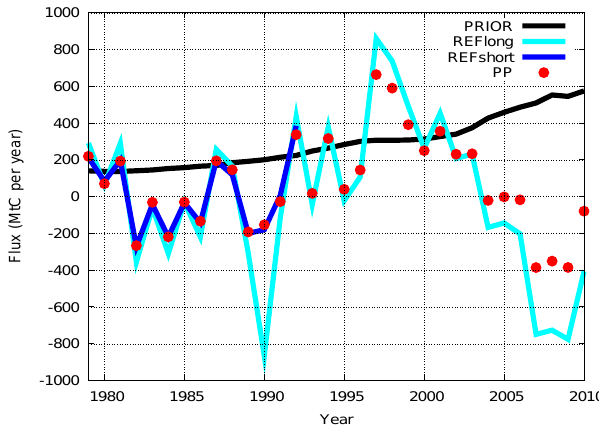
Fig. 2. Time series of the annual total CO 2 fluxes (including fos- sil fuel) in region Tropical Asia. In the sign convention, positive fluxes correspond to a net carbon source into the atmosphere. The black line (marked PRIOR) corresponds to the prior fluxes. The two coloured lines show the inverted fluxes for the reference 1979–2010 inversion (in cyan, marked REFlong) and for the reference 1979– 1992 inversion (in regular blue, marked REFshort). The 1979–2010 PP inversion appears with red disks